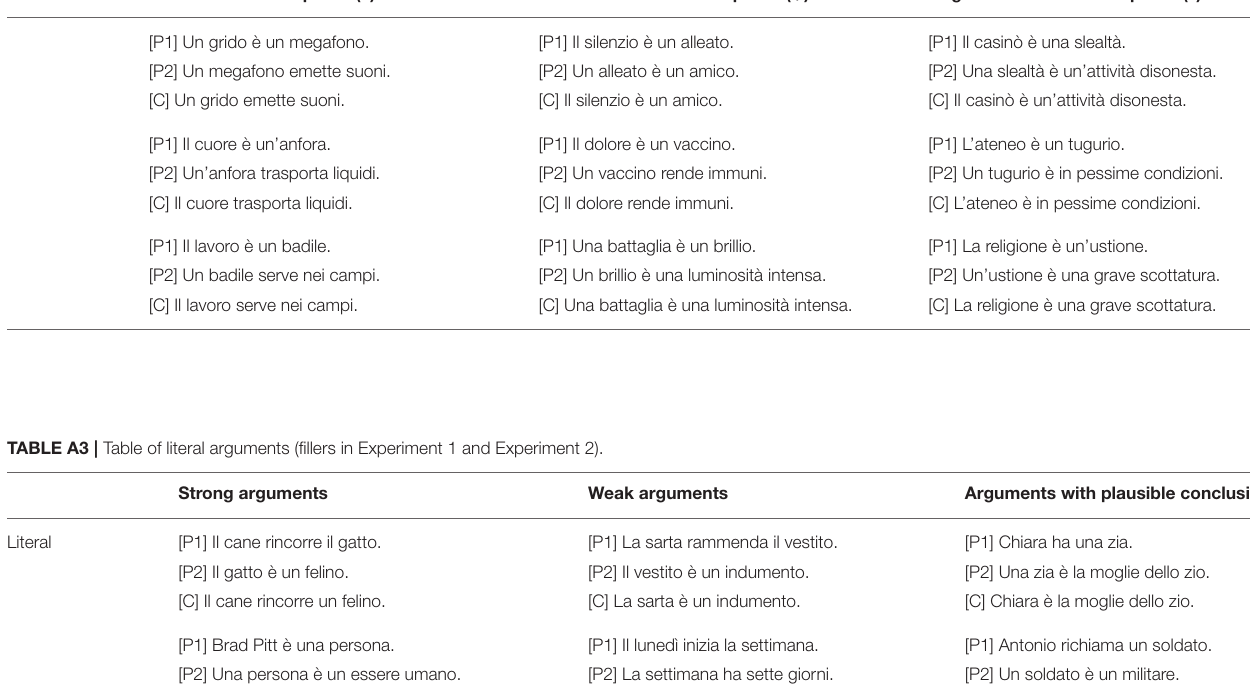
Non-emotive metaphors (0) Positive-valenced metaphors ( + ) Negative-valenced metaphors (–)